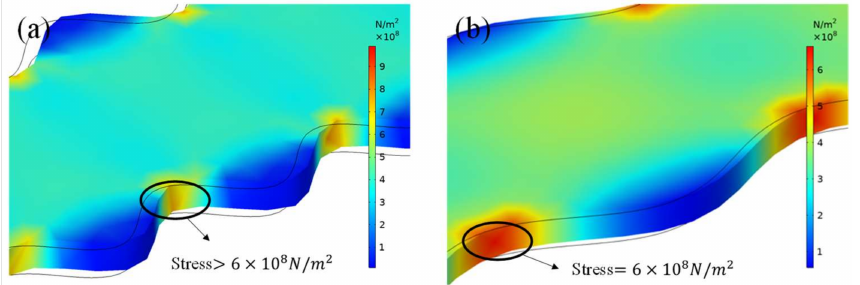
Figure 5. The strain distributions due to the sidewall profile roughness of the sensitive grids under the same load. The sidewall profile is assumed to be ( a ) T/W = 60% and ( b ) T/W = 120%.